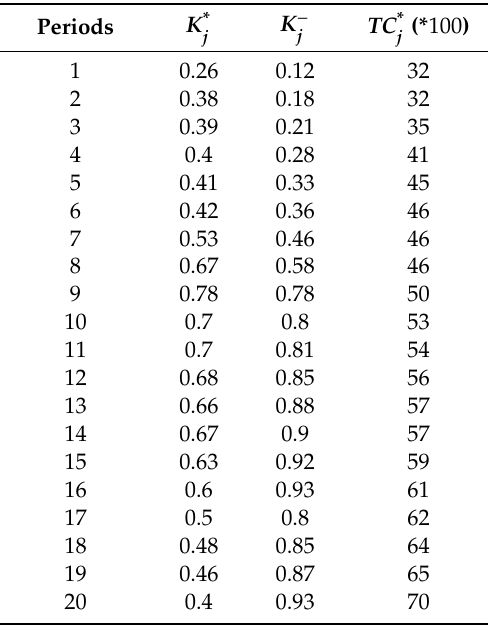
Figure 2. Influence of relevant parameters on the optimal inventory quantity. Table 2. TOPSIS (technique for order preference by similarity to ideal solution) analysis of parameters in this